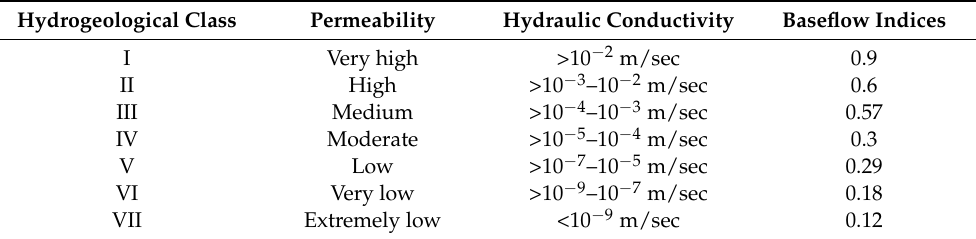
Table 2. The classification of the hydrogeological properties of the hard rocks in North Rhine-Westphalia and the associated BFI values obtained by calibration